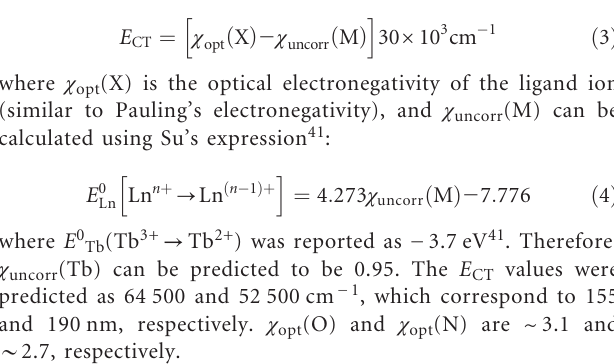
4 f 7 5 d 1 ] in the PLE spectra are attributed to the transition from the 7 F 6